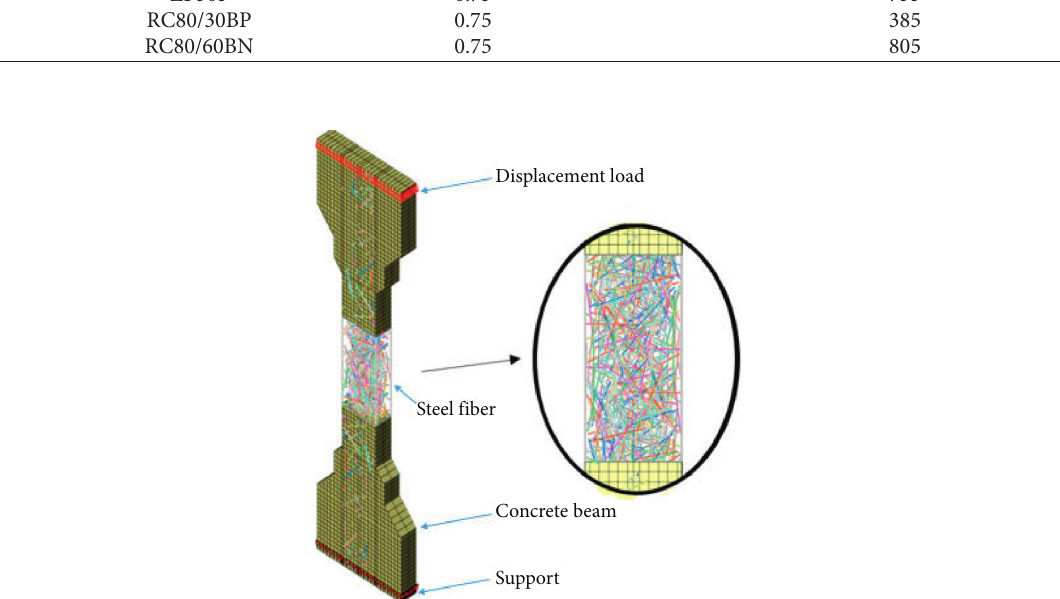
Figure 13: Meso-scale numerical model of the direct tensile